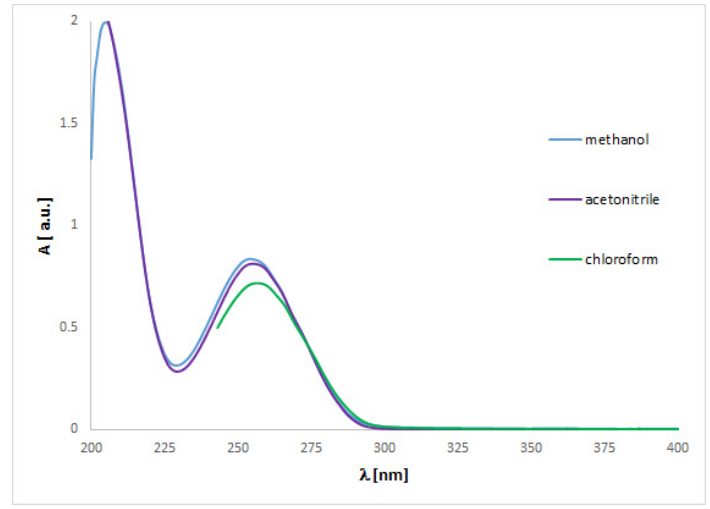
Figure 11. Experimental UV-vis spectrum of bifonazole 2 registered in methanol, acetonitrile and chloroform at 0.0025 mg/mL. Table 7. Calculated wavelength for first excited state ( λ 1 ) and maximum of absorption ( λ max ) for isoconazole 1 using different functionals: B3LYP —B3LYP/6-31G(d,p); 6311G(d,p) —B3LYP/6- 311++G(d,p); CAM —CAM-B3LYP/6-31G(d,p); APF —APF/6-31G(d,p); M06L —M06L/6-31G(d,p); M062X —M062X/6-31G(d,p), PBE1PBE —PBE1PBE/6-31G(d,p); wB97XD —wB97XD/6-31G(d,p). approach and solvents: methanol, acetonitrile and